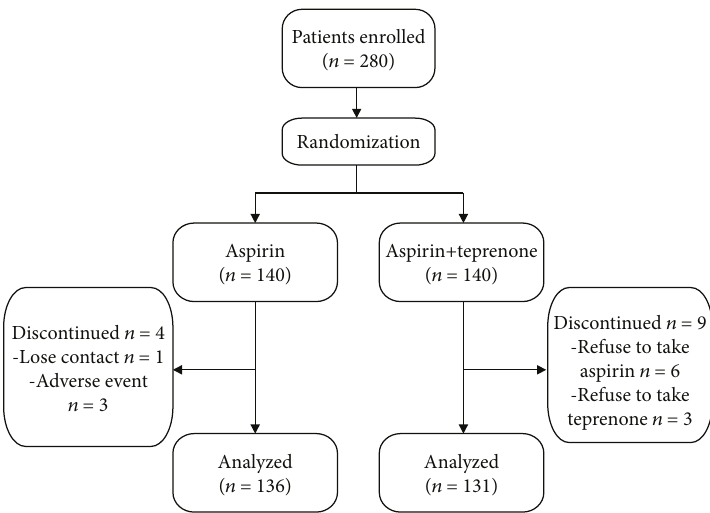
Figure 1: Study fl